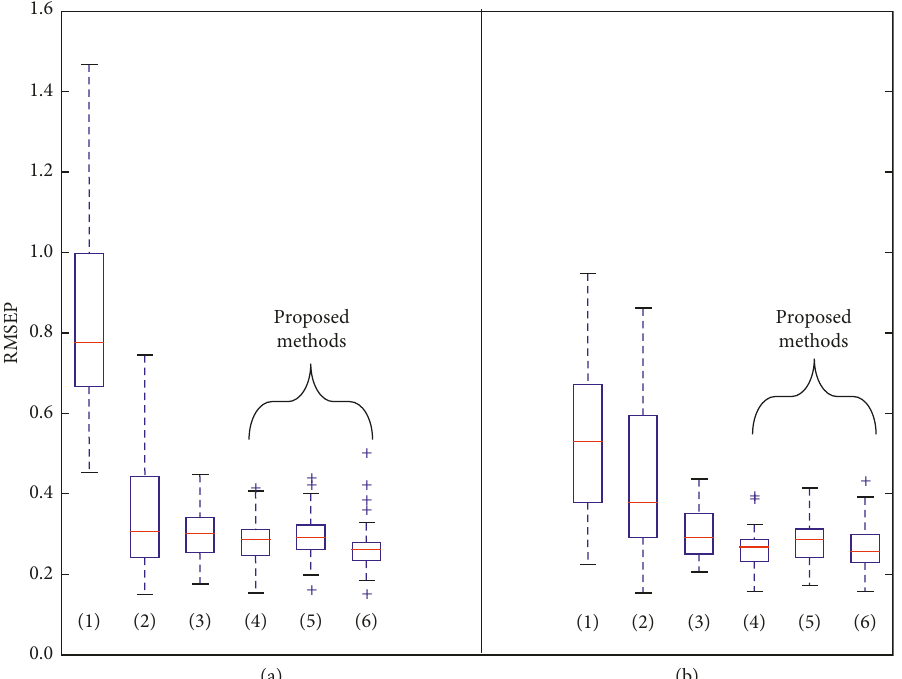
Figure 9: Box-and-whisker plot representation of the root-mean-squared error of prediction of the cross validation strategy (50 folds, random train test split of 70/30% of the data) for the friction modifier compound of ATF A. In (a), the RMSEP values for the transmission spectra are shown, and in (b), the RMSEP values for the absorbance spectra are shown. Boxplot (1) is without standardization, (2) is with a single SNV transformation on the full spectrum, (3) is with optimized LSNV, (4) is with optimized Dynamic DLSNV, (5) is with optimized PSNV, and (6) is with optimized